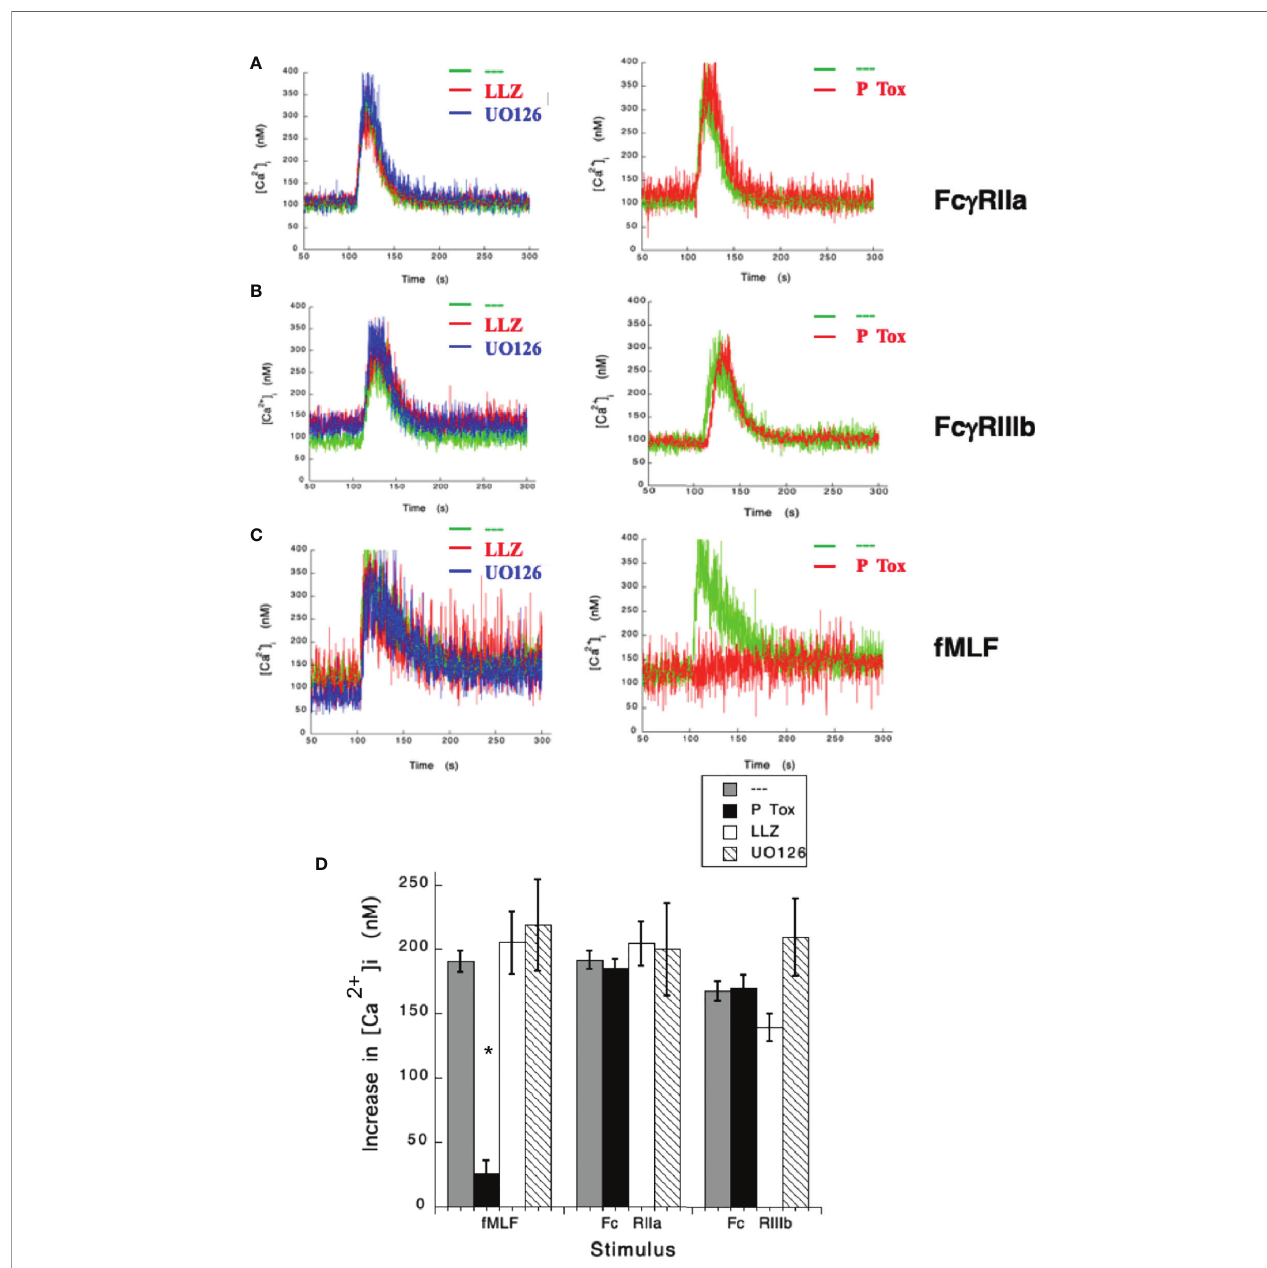
FIGURE 2 | Fc g receptor-mediated increase in [Ca 2+ ] i is independent of TAK1 and MEK. Fura-2-loaded human neutrophils in PBS with Ca 2+ and Mg 2+ were left untreated (green line), or treated with 10 nM LLZ 1640-2 (LLZ) a TAK1 inhibitor, or with 50 µM UO126, a MEK inhibitor, or with 2 m g/ml Pertussis toxin (P Tox), before being stimulated by aggregating Fc g RIIa (A) , or by aggregating Fc g RIIIb (B) , or with 10 nM fMLF (C) . Arrow indicates the moment when the stimulus was added. Changes in cytosolic calcium concentration ([Ca 2+ ] i ) were assessed by measuring the variations in fl uorescence as described in material and methods. Tracings are representative of three experiments with similar results. (D) Increments in [Ca 2+ ] i were calculated by subtracting the baseline value from the maximum value after stimulation. Data are mean ± SEM of three independent experiments. Asterisks (*) denote conditions that were statistically different from untreated cells (p <